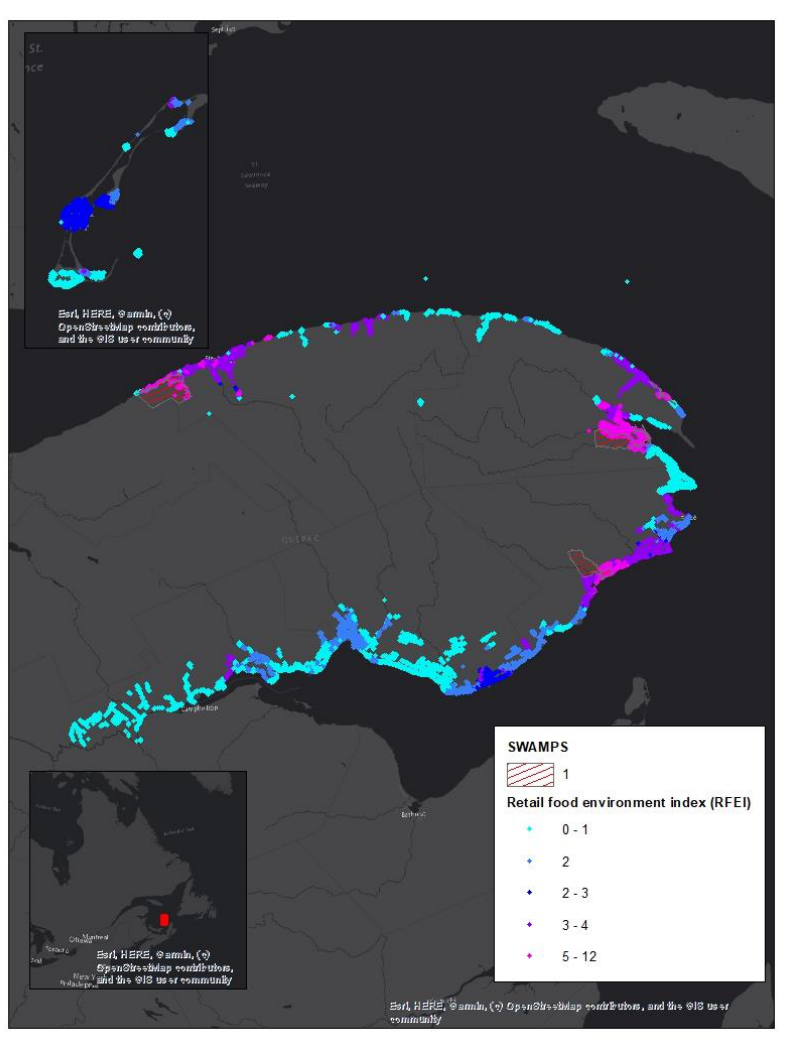
Figure 4. Swamp area localization.